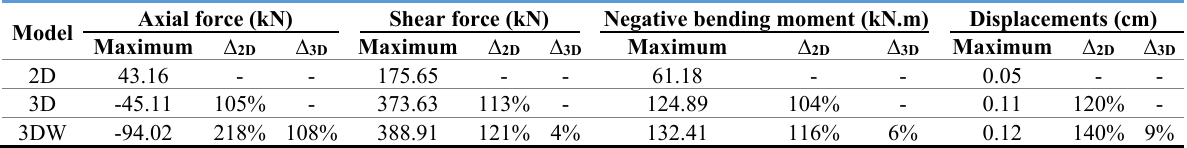
Table 8. Maximum forces and displacements in the support beam of Wall